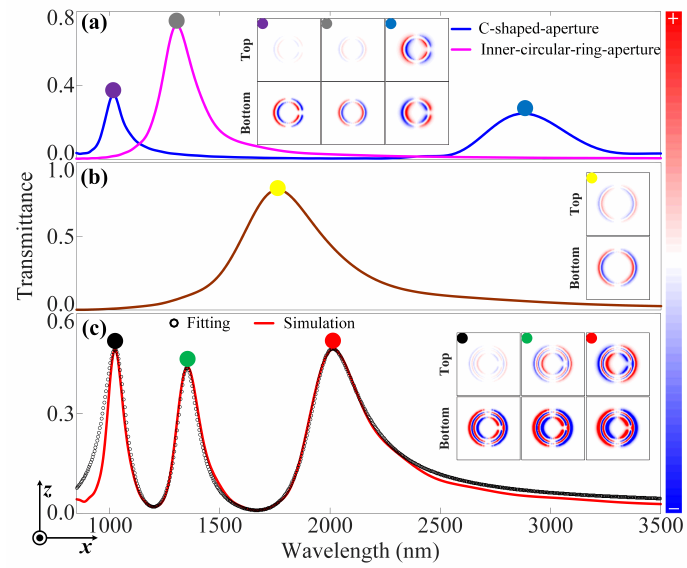
Figure 2. DFRs in a hybrid RMM. The near-infrared transmittance of ( a ) the individual CSA meta- surface, ( b ) the individual CRA metasurface, and ( c ) the hybrid RMM. The charge distributions at the labeled wavelengths are shown in the insets, which represent the top (T) panel at the Ag/air interface and the bottom (B) panel at the Ag/quartz interface . The solid red curve and black circle in ( c ) represent simulation and fitting results, respectively. The geometrical parameters of the unit cell of these metasurfaces are given as follows: P x = P z = 600 nm, R 1 = 100 nm, R 2 = 135 nm, α = 20°, w = 25 nm, and R 3 = 175